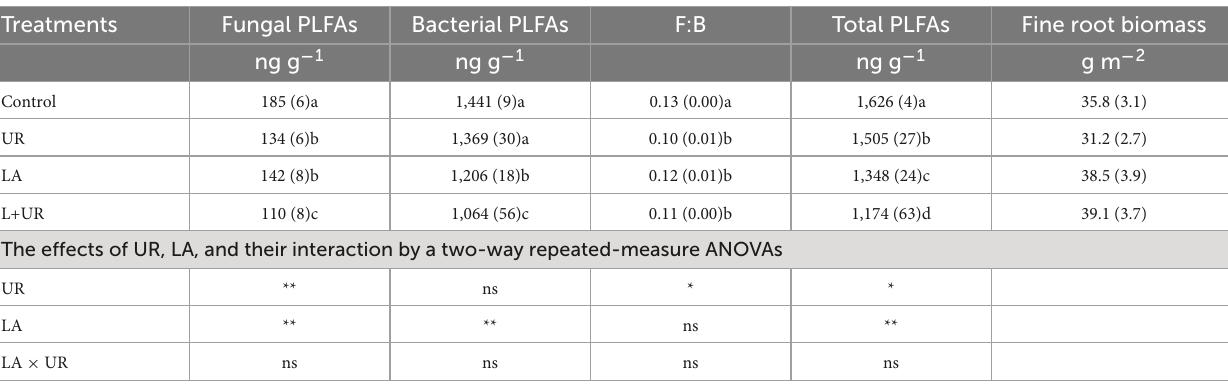
TABLE 2 Effects of lime application (LA), understory removal (UR), and their interactions (LA × UR) on soil microbial PLFAs, and Eucalyptus fine root biomass in a southern Chinese Eucalyptus